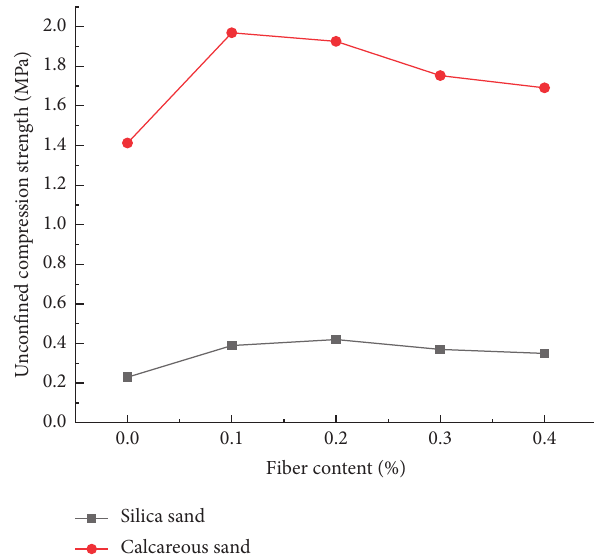
Figure 6: Unconfined compression strength of samples with different fiber contents.